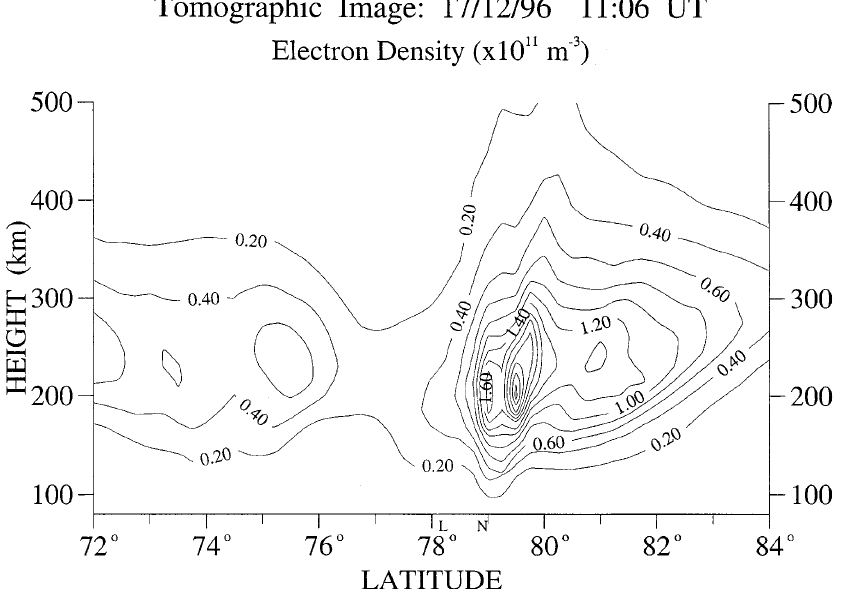
Fig. 2. Tomographic image of electron density reconstructed from observations of a southbound satellite pass that crossed 75 (cid:176) N at 1106 UT on 17